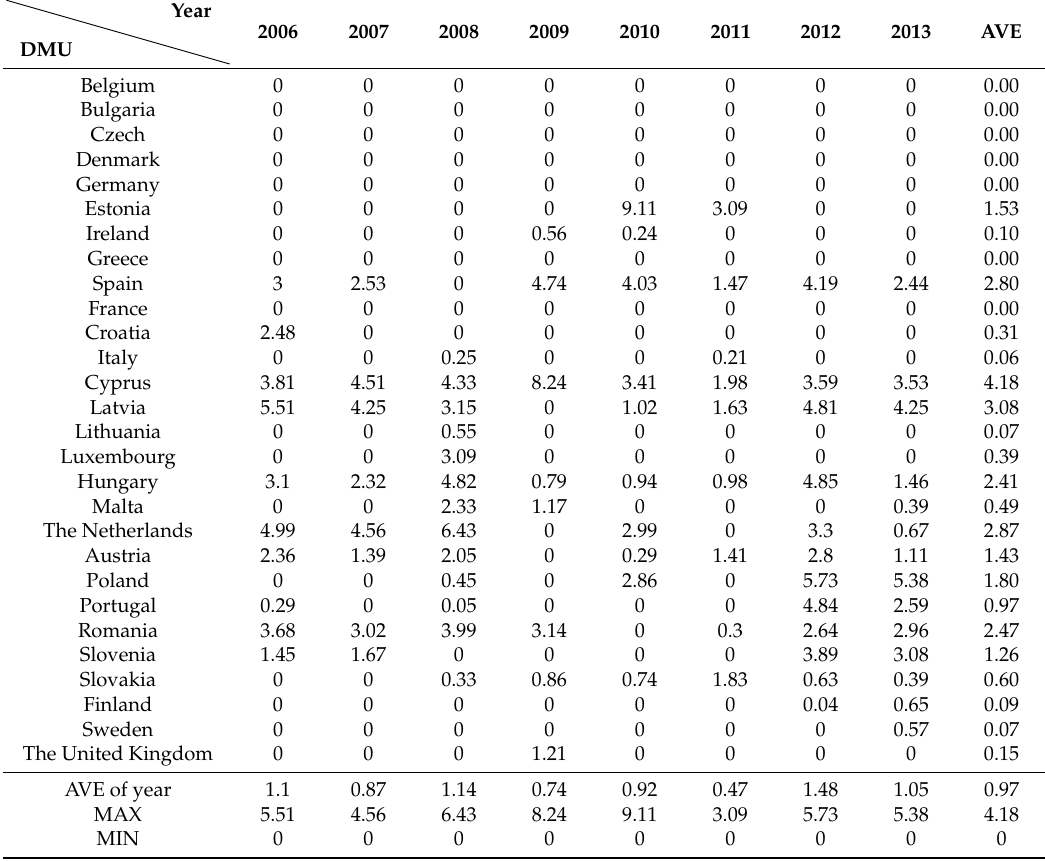
Table 9. Adjusted GDP value of EU countries. Unit: